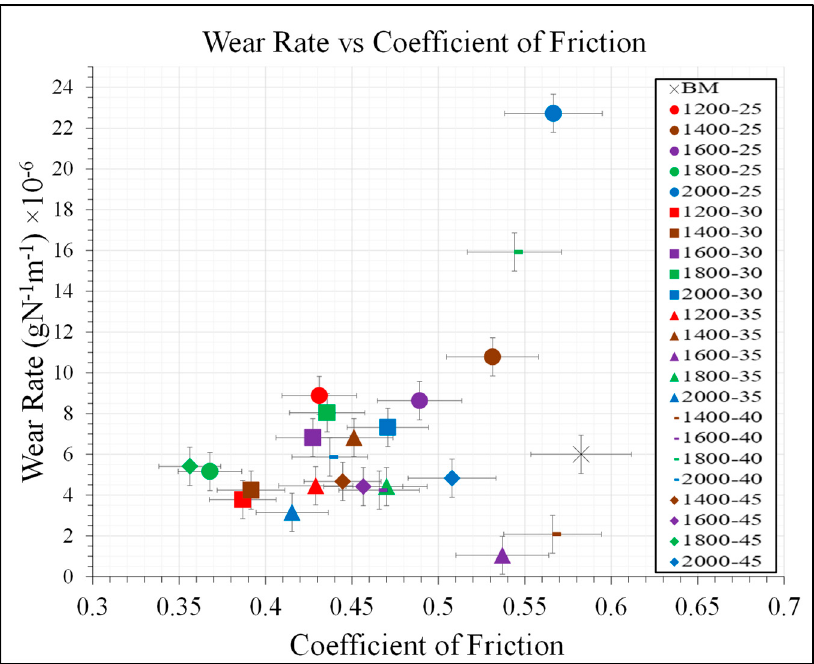
Figure 18. Friction coefficients vs. wear rates of FSPed samples after sliding tests under starved lubrication conditions, normal contact pressure of 0.24 MPa, sliding speed of 2.88 m/s, and sliding distance of 1500 m.